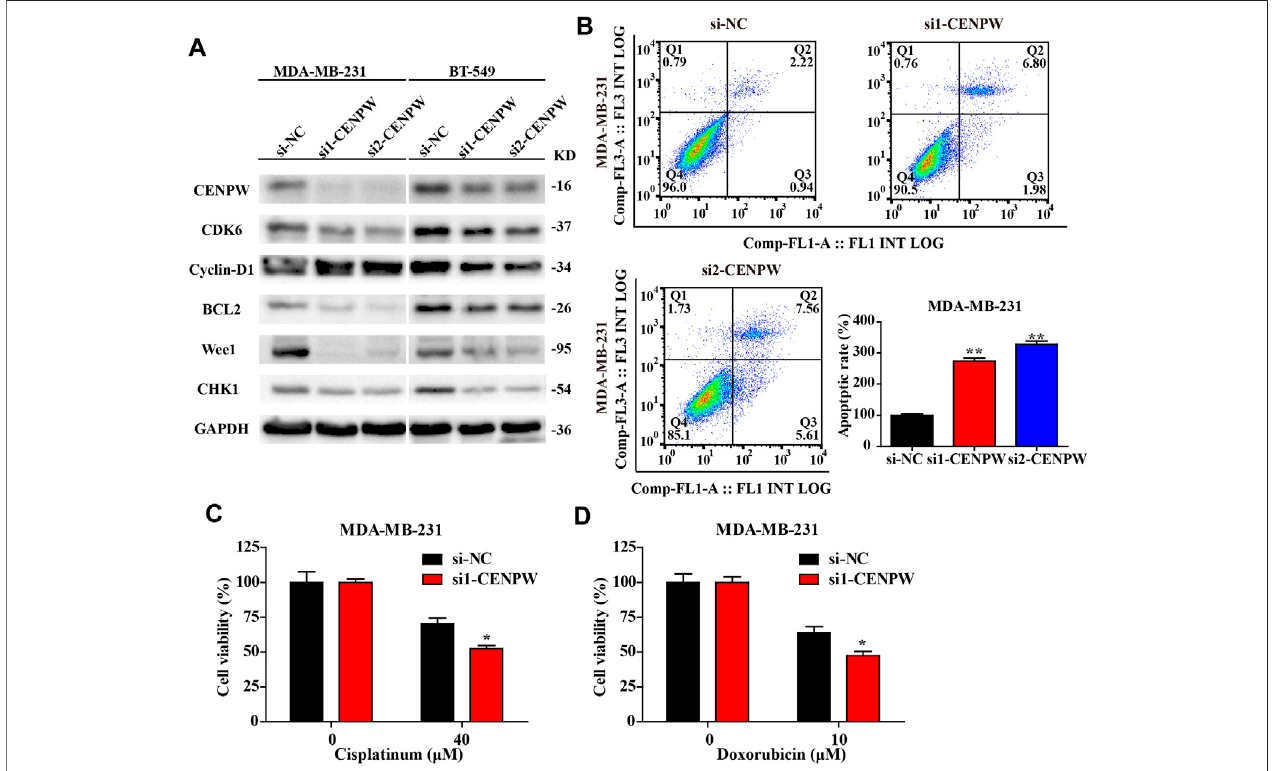
FIGURE 11 | Knockdown of CENPW decreased the expression level of related pathway proteins and increased the apoptosis rate of breast carcinoma cells. (A) Westernblot assay ofcontrol and CENPW knockdown cells. (B) The apoptosis rate wasassessed by fl ow cytometry. (C,D) The cytotoxicity ofcisplatin and doxorubicn in the CENPW inhibited breast carcinoma cells. * p < 0.05, ** p < 0.01 compared with si-NC